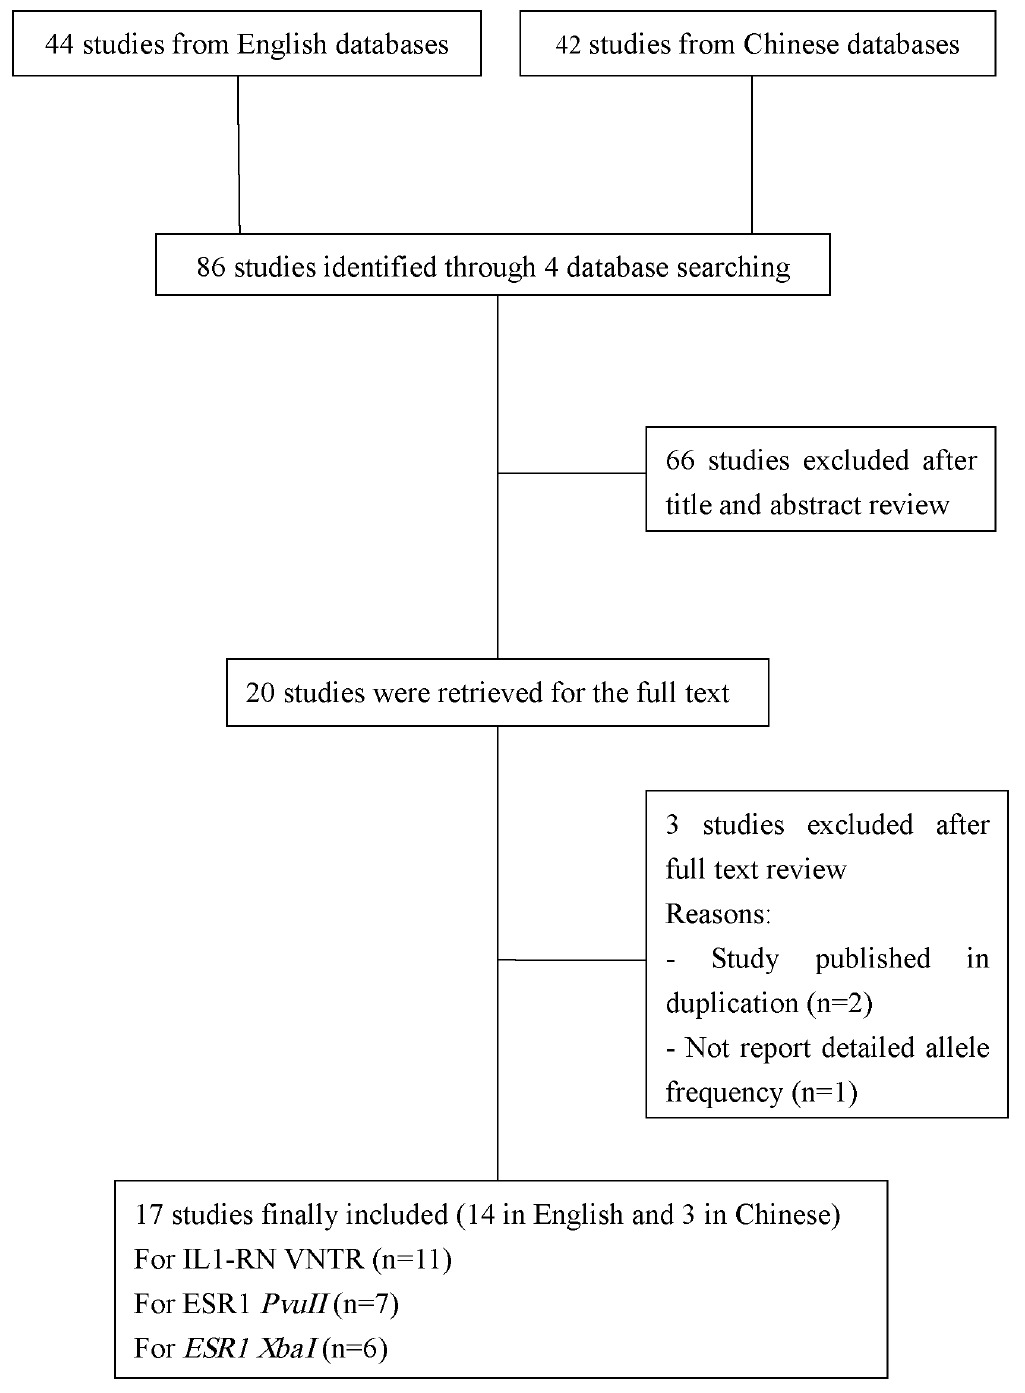
Figure 1. Flow diagram of studies included in the meta-analysis.